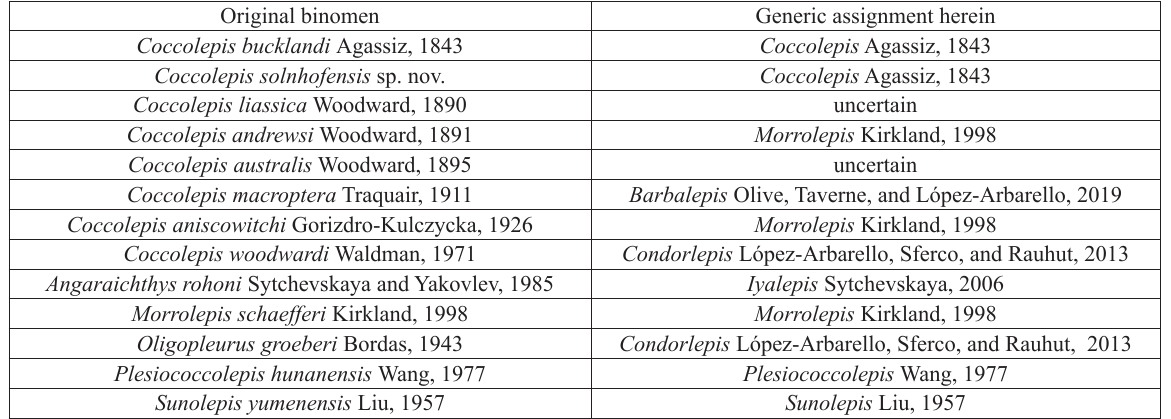
Table 1. Taxonomic status of the species currently classified in